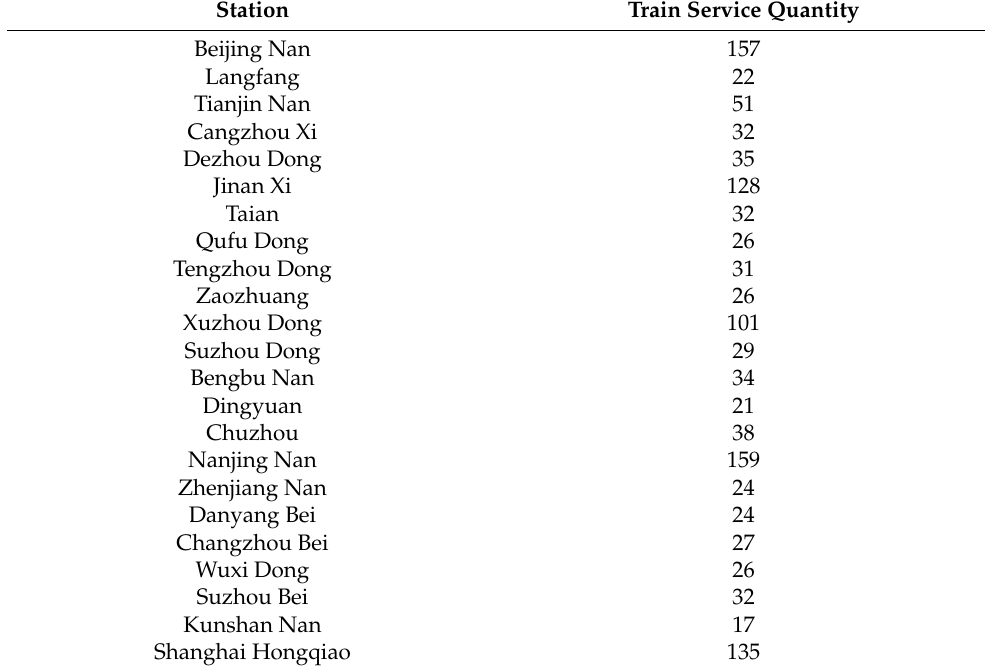
Table 7. The service plan.